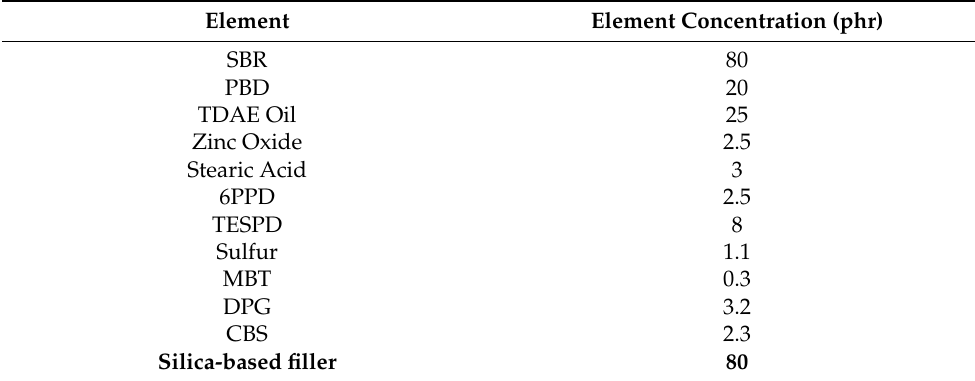
Table 1. Nano-composite composition in phr.